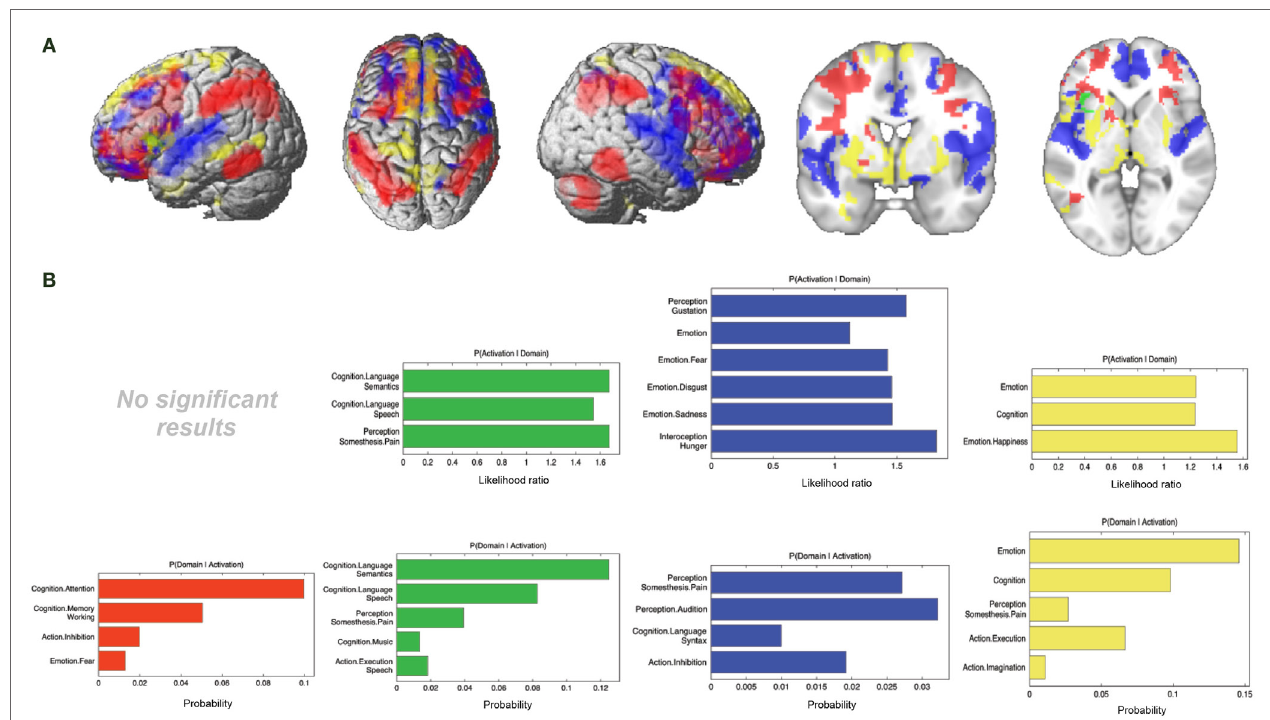
FigUre 7 | specific connectivity of seed and functional characterization . (a) Specific connectivity for RS-FC (red), MACM (green), SC (blue), and PT (yellow). An additional cluster extent threshold of 100 voxels was applied. (B) Behavioral domains from the BrainMap database significantly associated with the specifically connected regions shown in (a) (FDR-corrected for multiple comparisons, p <